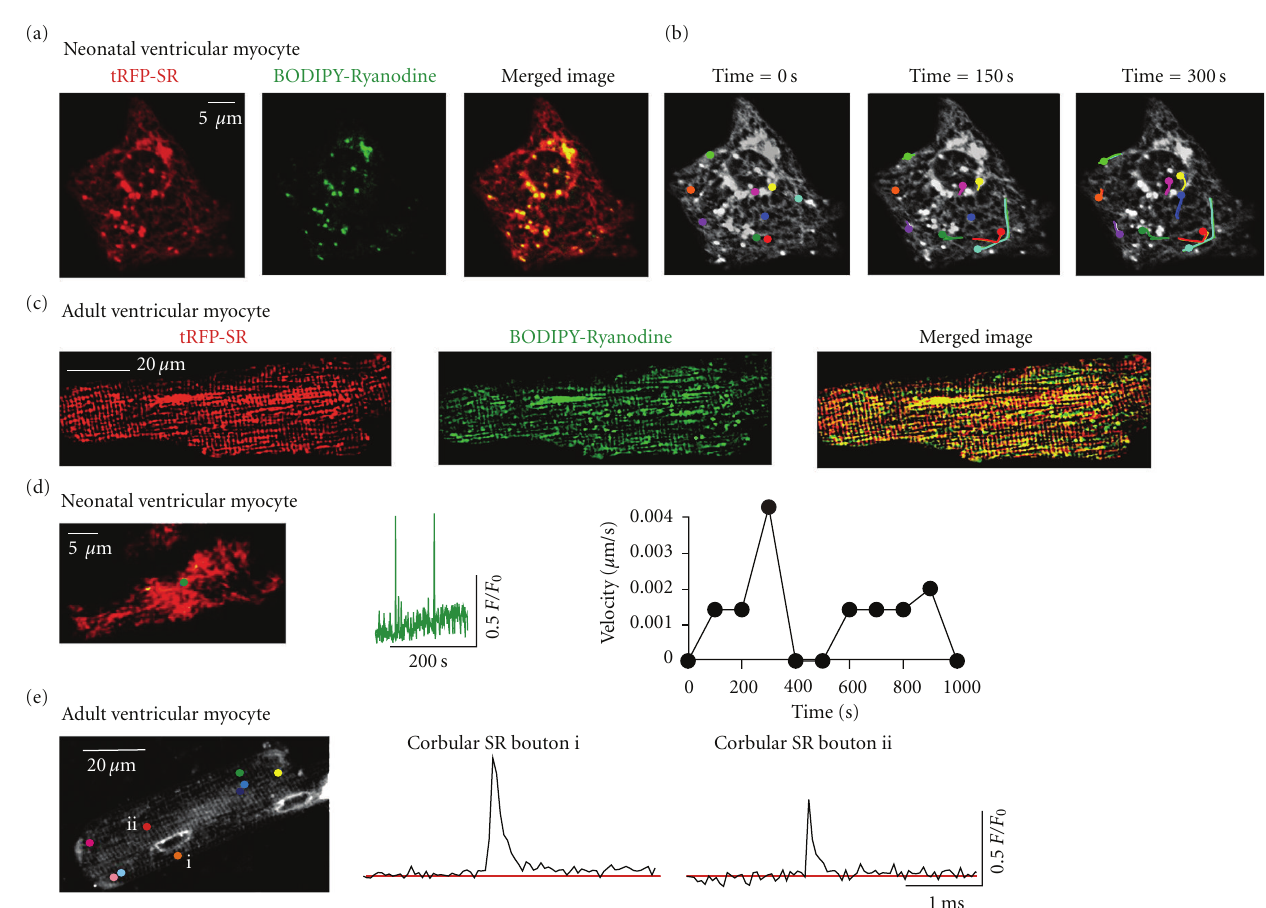
Figure 6: Expression of functional ryanodine receptors in motile corbular SR boutons. (a) Confocal image of a neonatal ventricular myocyte expressing tRFP-SR (left), labeled with BODIPY FL-X Ryanodine (center) and merged image (right). (b) Time-lapse confocal images of neonatal ventricular myocyte from panel A expressing tRFP-SR and labeled with BODIPY FL-X Ryanodine. Images shown were obtained 0, 150, and 300 seconds after the initiation of the experiment. Motile corbular SR boutons are labeled with colored circles. (c) Confocal image of adult ventricular myocyte expressing tRFP-SR (left), labeled with BODIPY FL-X Ryanodine (center) and merged image (right). (d) TIRF image (left) of a representative neonatal myocyte expressing tRFP-SR loaded with fluo-4. Green dot represents corbular SR bouton of interest. The plot in the center shows the time course of Ca 2+ spark activity in this corbular SR bouton. The plot to the left shows the velocity of the corbular SR bouton marked by the green dot as a function of time. (e) Confocal image (left) of a representative adult ventricular myocyte expressing tRFP-SR loaded with fluo-4 AM. Colored dots mark corbular SR boutons in this cell. The two plots in this panel show the time-course of spontaneous Ca 2+ sparks in corbular SR boutons i and ii